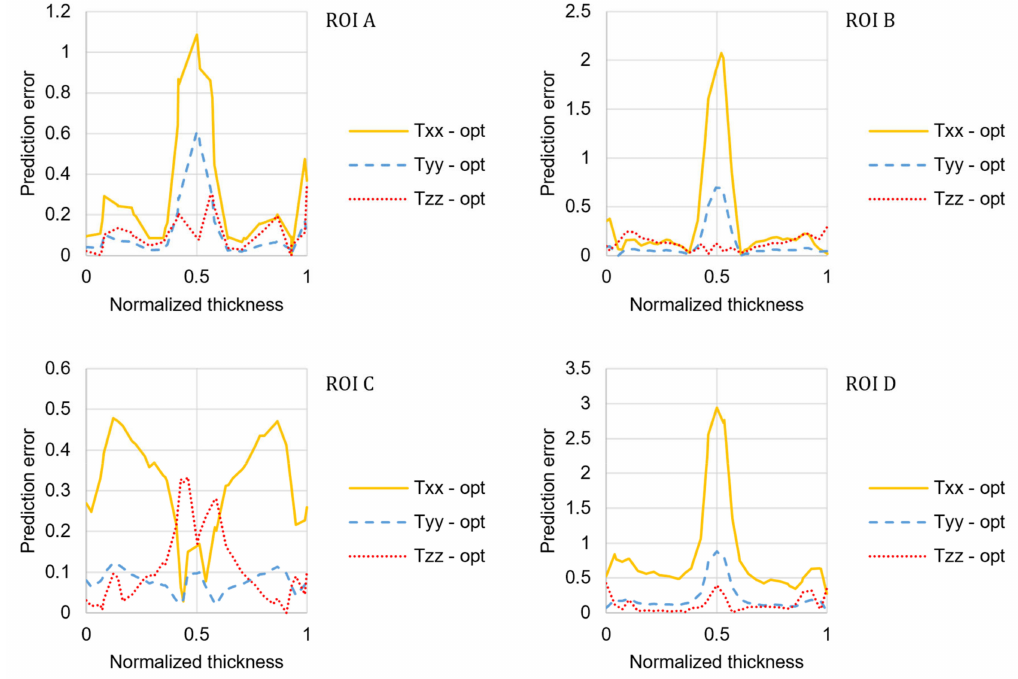
Figure 8. Error distribution for the predictions obtained with the optimized coefficients of the RSC model.